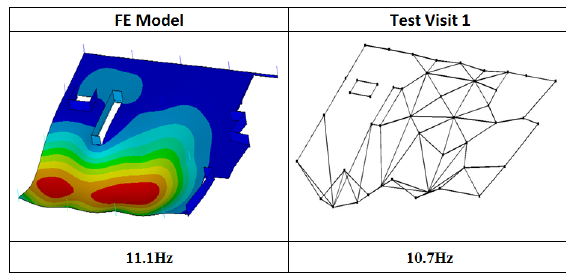
Fig. 7. Comparison of first mode of vibration of the slab for the 3D FE model and